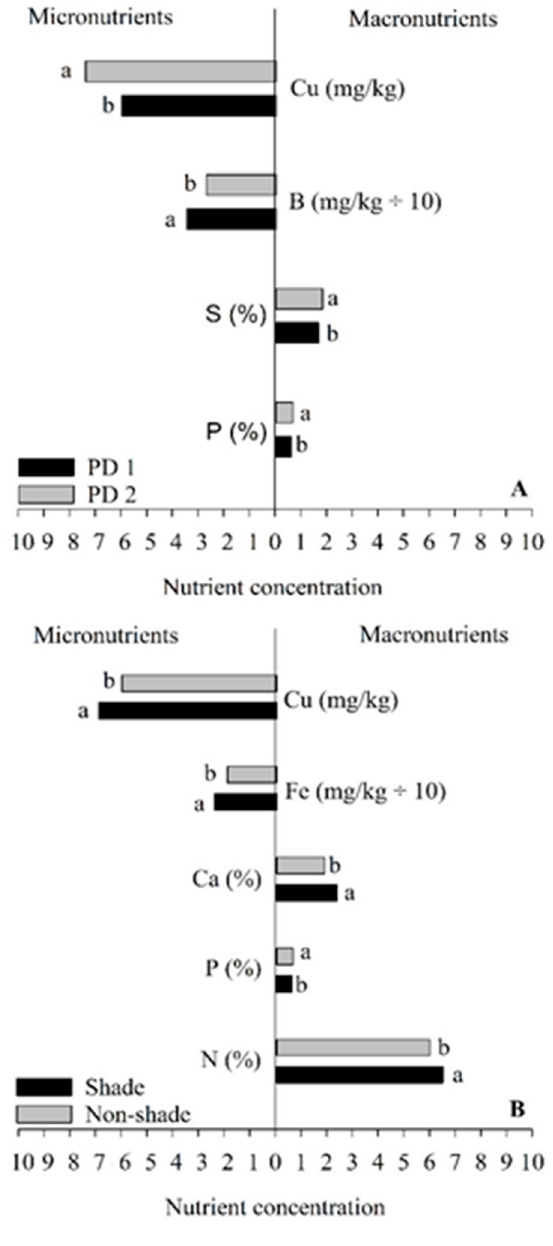
Figure 4. Main effects of planting date (PD) ( A ) and shade cloth ( B ) on the dry weight concentrations of copper (Cu), boron (B), sulfur (S), phosphorous (P), iron (Fe), calcium (Ca), and nitrogen (N) in high tunnel-grown arugula. Columns followed by the same letter(s) are not significantly different according to Tukey’s Honest Significant Difference Test ( p < 0.05).